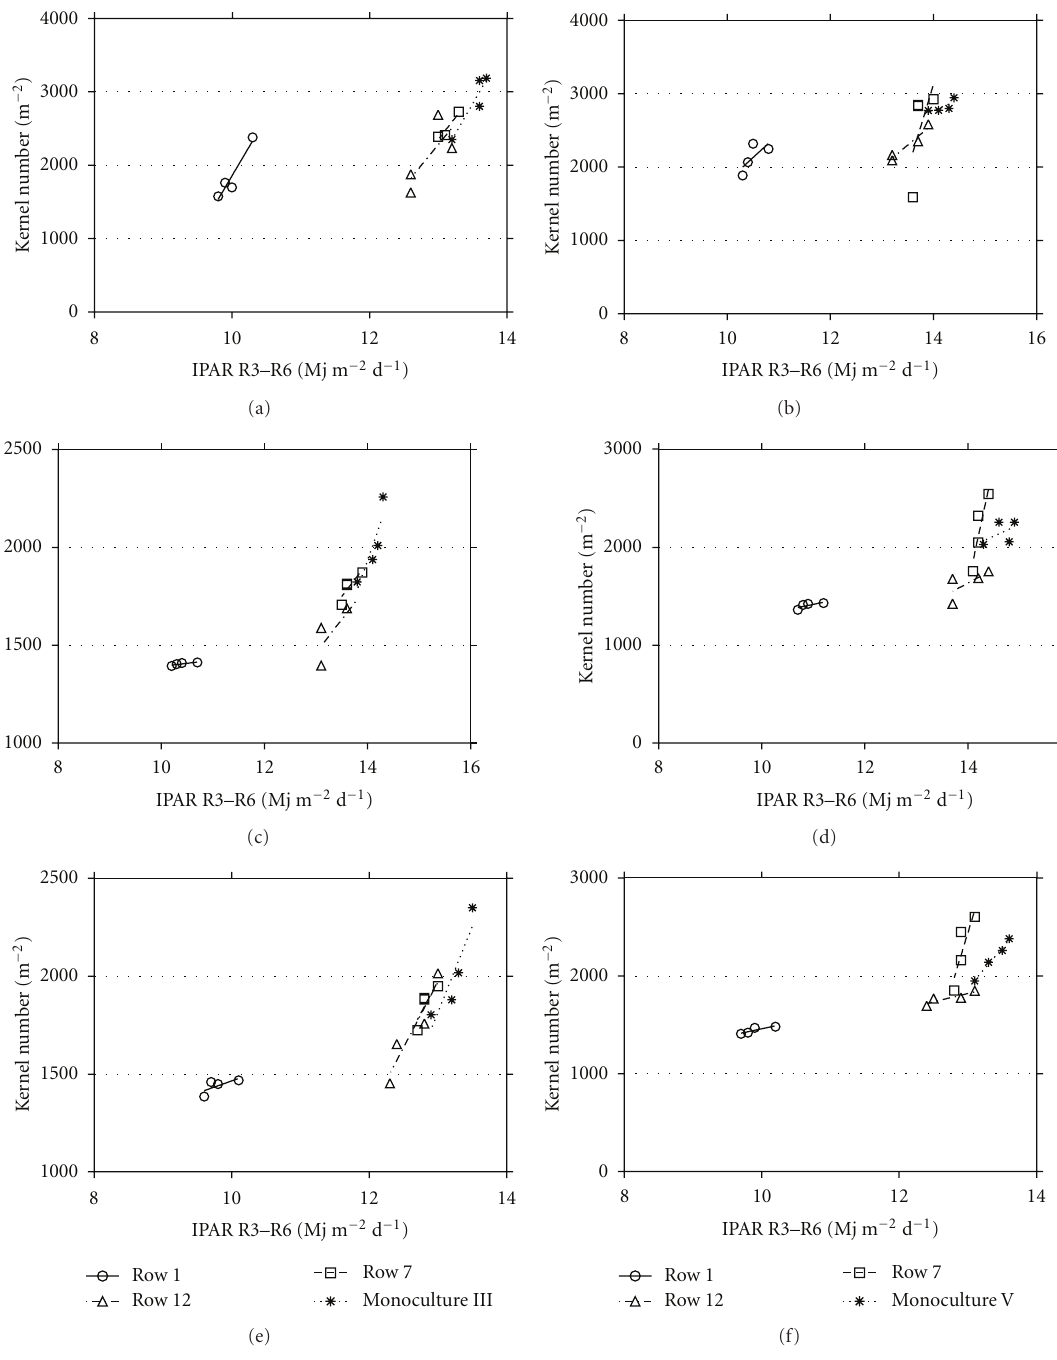
Figure 9: GNUA in relation to IPAR within R3–R6 in monocultures and in the strips in row 1, 7 and 12 of soybeans MG III-corn strips during C1 (a), C2 (c), and C3 (e) and in soybeans MG V strips during C1 (b), C2 (d), and C3